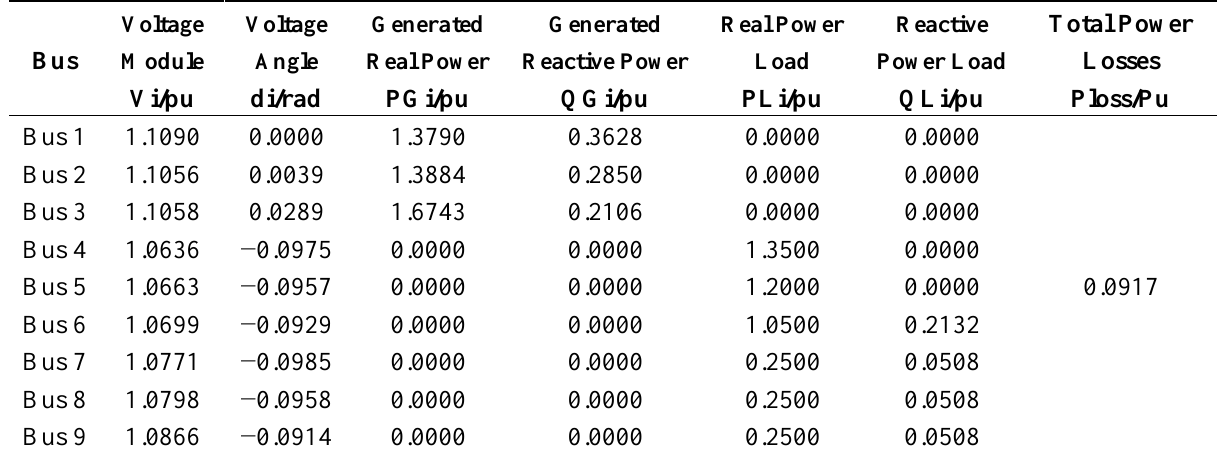
Table 4. Load flow solution of the test system with OOP.